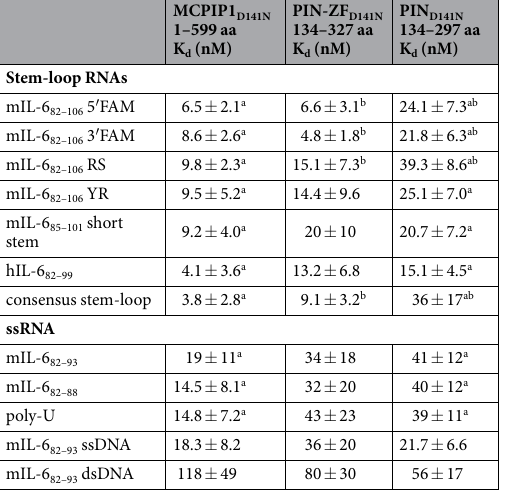
Table 2. Calculated equilibrium dissociation constants of MCPIP1 complexes with selected oligonucleotides. The analyzed proteins were mutated forms of MCPIP1 and its ribonuclease domain (MCPIP1 D141N , PIN- ZF D141N , and PIN D141N ). K d values were determined using DynaFit4 software with the implemented model of sequential binding of two proteins to a single oligonucleotide with a single dissociation constant. Errors are shown as standard deviations, n = 3. Statistical significance (P value < 0.05) between selected groups is shown by the following indexes: a and b for comparison of the MCPIP1 D141N with PIN D141N and PIN-ZF D141N with PIN D141N groups, respectively. Differences observed between the MCPIP1 D141N and PIN-ZF D141N groups are not statistically